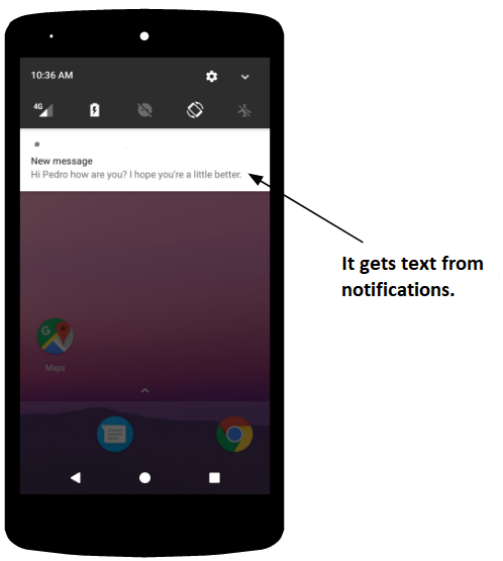
Figure 3. Mobile application running in the